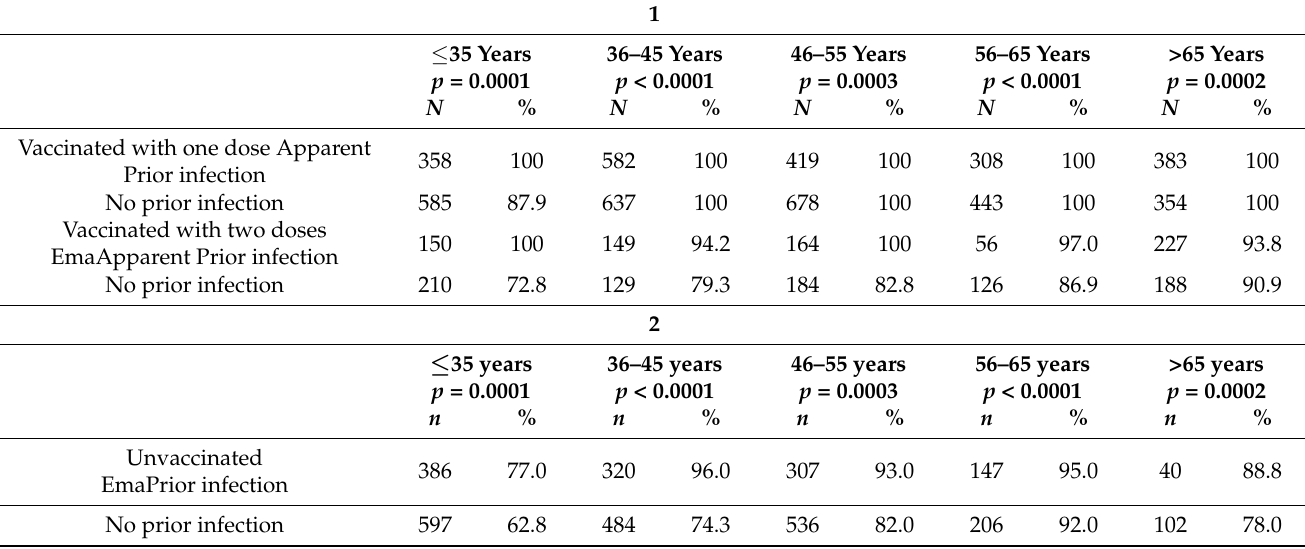
Table 2. 1. Percentage positivity by age group, vaccination dose and prior infection status ( N represents the total number of individuals in each corresponding age group). 2. n represents the number of seropositive individuals in each corresponding age group.